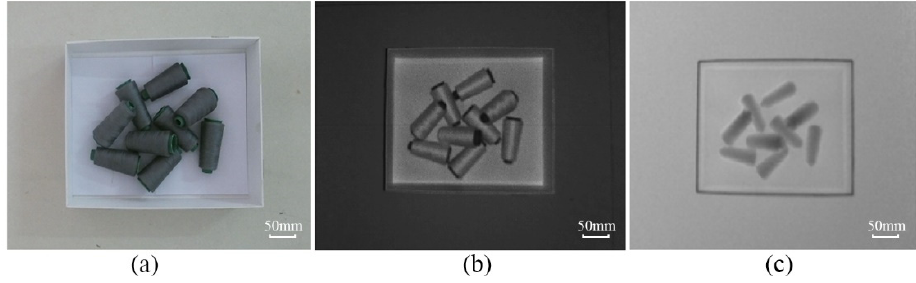
Figure 3. Kinect V2 acquired images: ( a ) RGB image; ( b ) IR image; ( c ) Depth image.